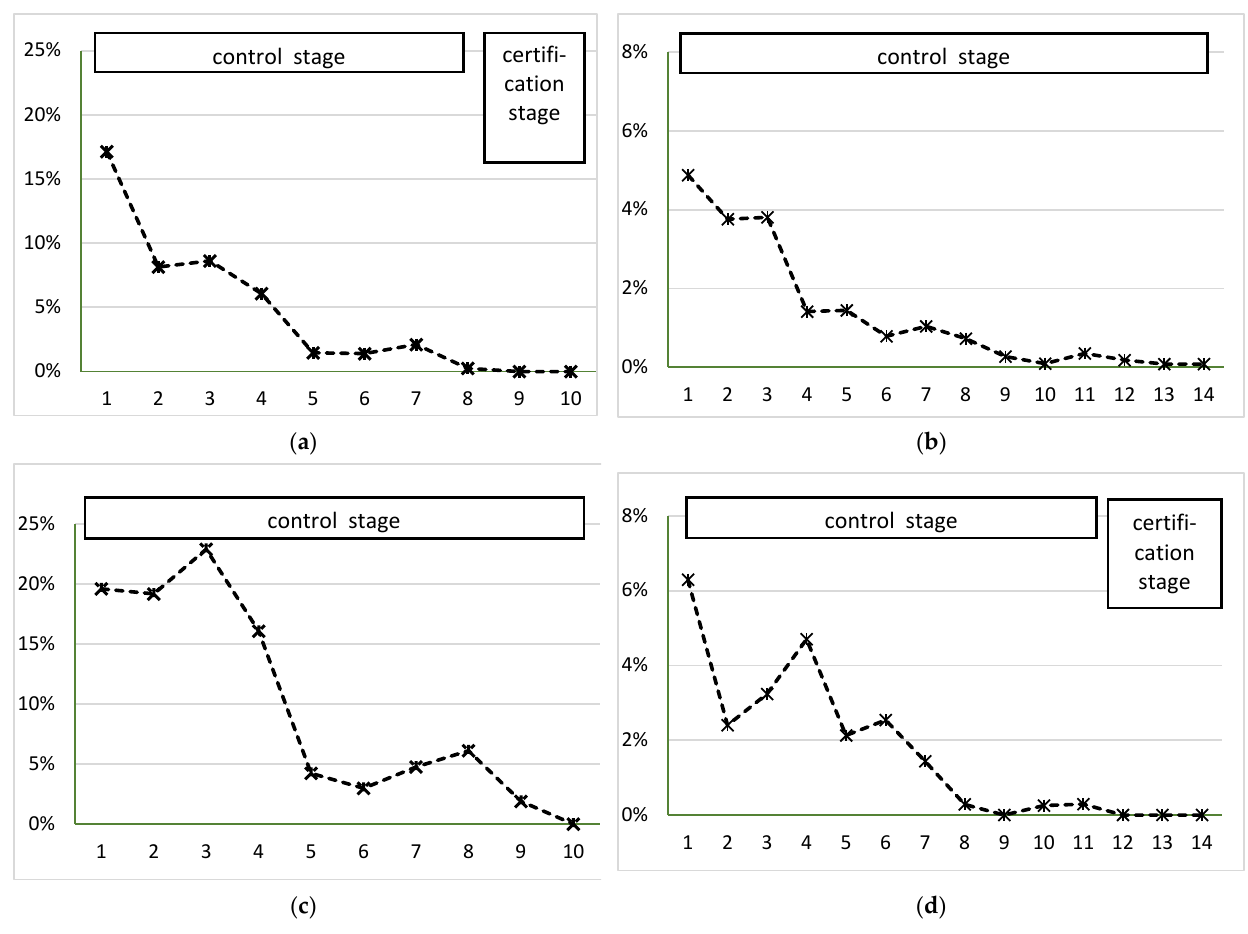
Figure 2. Prevalence of MAP shedders in 4 dairy herds enrolled in the Thuringian Johne’s Disease control program during 10 or 14 consecutive years of enrollment. ( a ) A herd with 420 dairy cows. Certification stage achieved after 8 years in the control stage. ( b ) A herd with 990 dairy cows. Long tailing-out period, with only one MAP shedder detected in years 10, 13 and 14 of enrollment. ( c ) A herd with 300 dairy cows. High initial prevalence, but no MAP shedders after 8 years in control stage. ( d ) A herd with 350 dairy cows. No MAP shedders after 8 years in control stage; long tailing- out period, with only one MAP shedder detected in years 10 and 11 of enrollment, respectively.